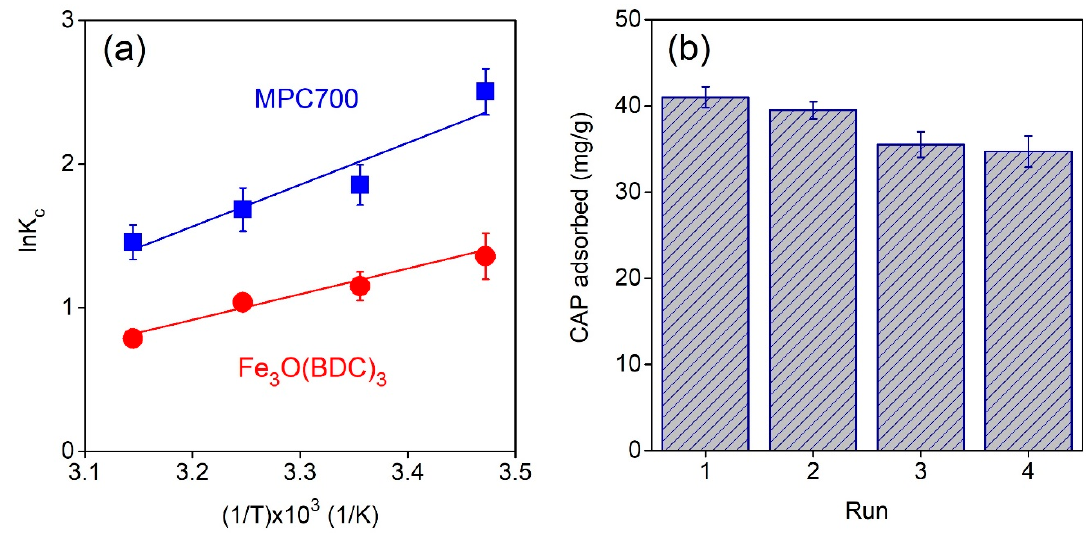
Figure 7. Thermodynamic ( a ) and recyclability ( b ) studies. Table 7. Thermodynamic parameters for the adsorption of